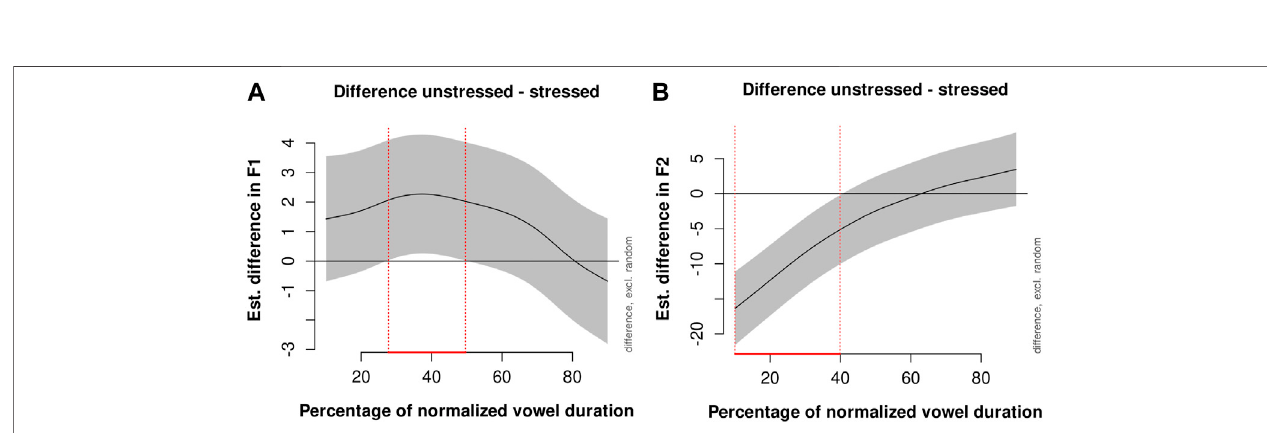
FIGURE 3 | Difference smooth in fi rst (A) and second (B) formants between vowels in unstressed and stressed positions with a 95% con fi dence interval.